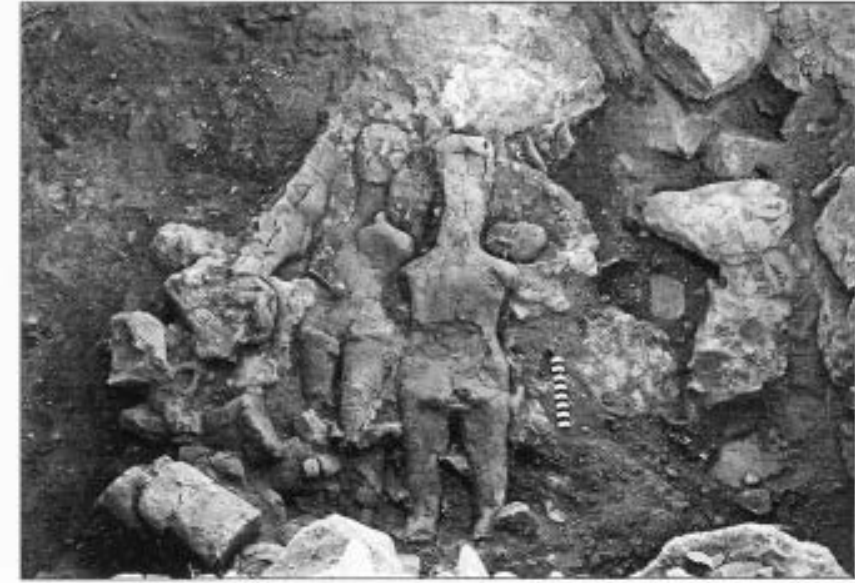
Figure 2 The cache of statues in situ at 'Ain Ghazal during excavation, 1983 (scale bar 15cm). as a block, so that skilled excavation could proceed later away from the site, at a pace consistent with the needs of the statues. The removal involved intensive team effort and, mercifully, was successful. With the cache installed in a crate, safely lifted, and